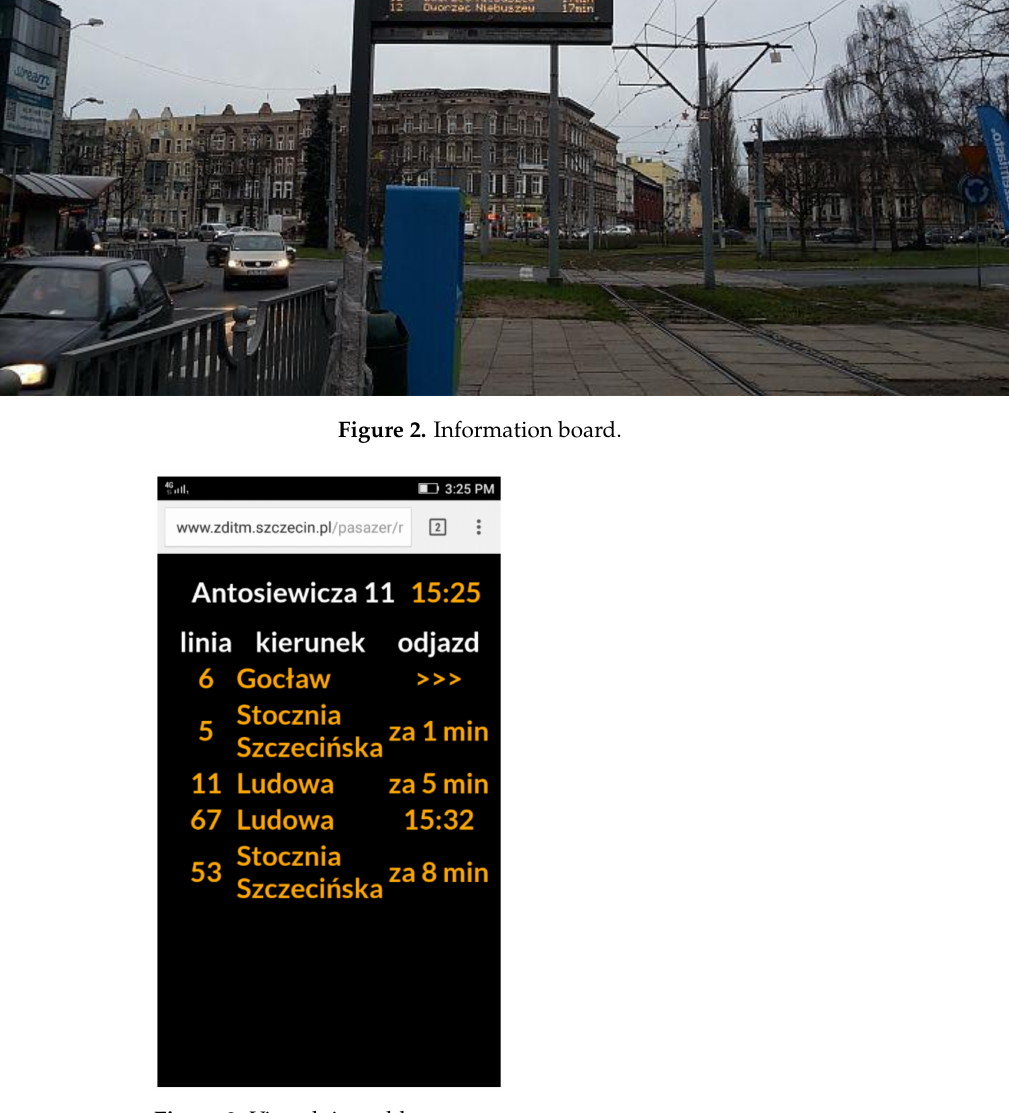
Figure 3. Virtual